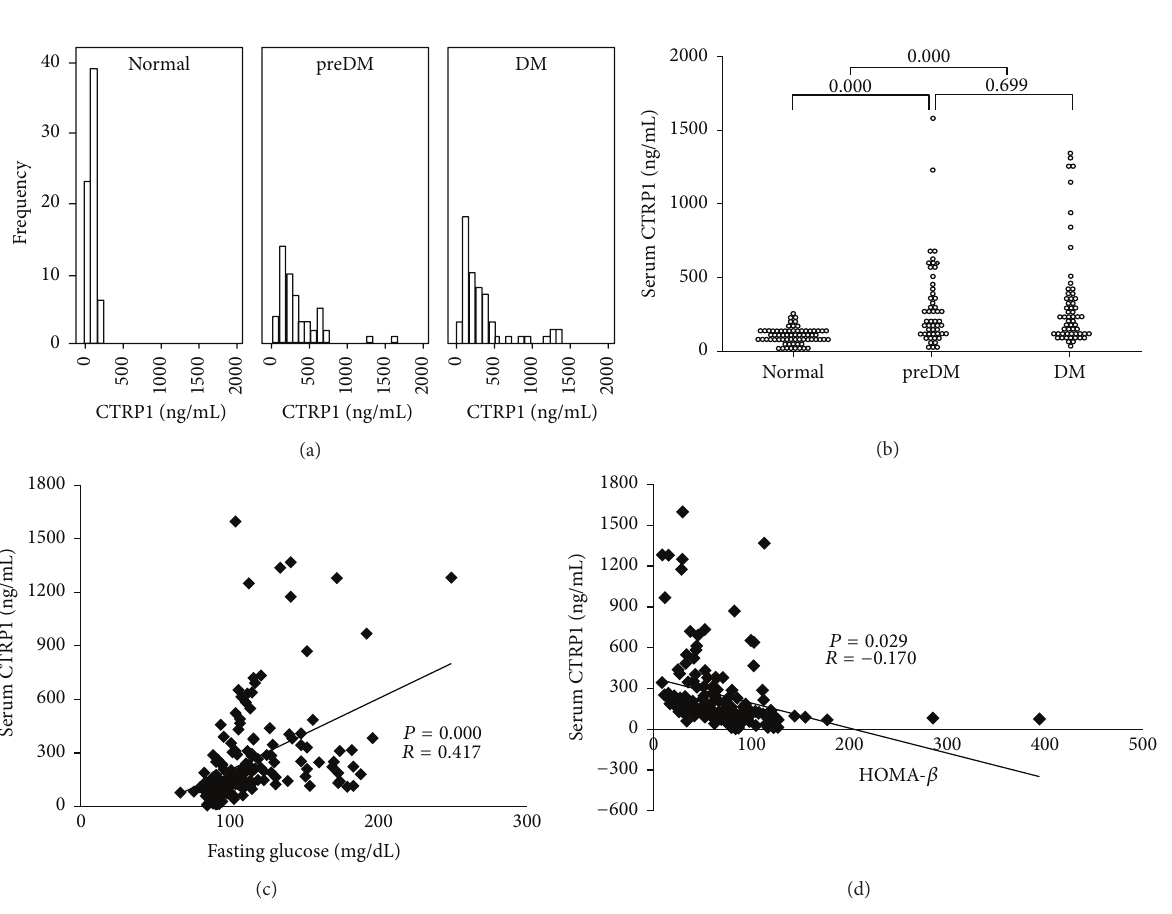
Figure 1: Circulating CTRP1 levels in healthy subjects and subjects with DM. Circulating CTRP1 levels were measured in three groups: normal, preDM, and DM patients. (a) Frequencies and distributions of circulating CTRP1 levels in three groups. (b) Circulating CTRP1 levels and statistical significance within three groups. Correlation analyses between circulating CTRP1 and fasting blood glucose levels (c) and HOMA- 𝛽 (d). preDM, prediabetes mellitus; DM, diabetes mellitus; HOMA- 𝛽 , homeostasis model assessment- 𝛽